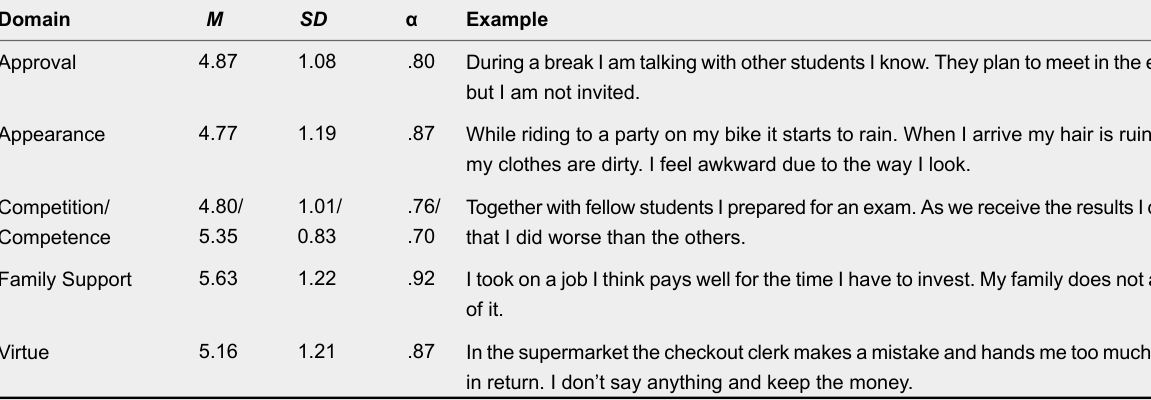
Descriptive Statistics for Contingencies of Self-Worth and Example Setback Descriptions From the Rank Order Tasks Employed in Study